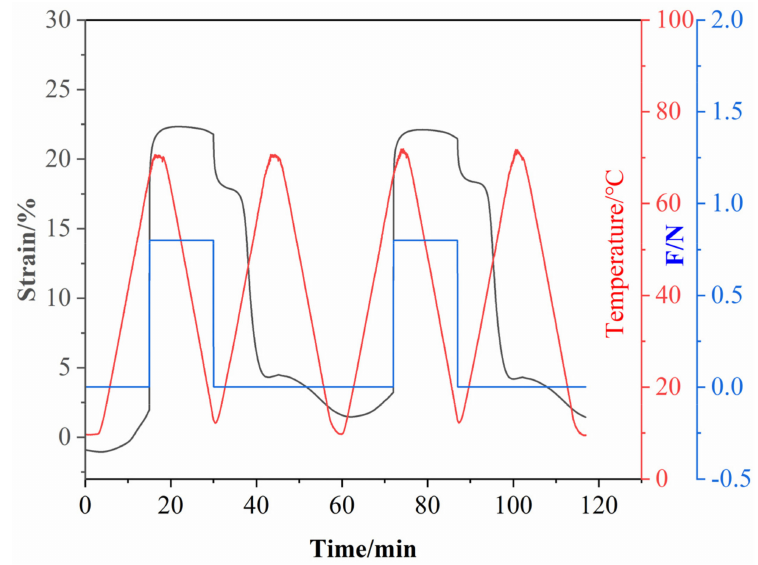
Figure 11. Two Shape memory cycles for